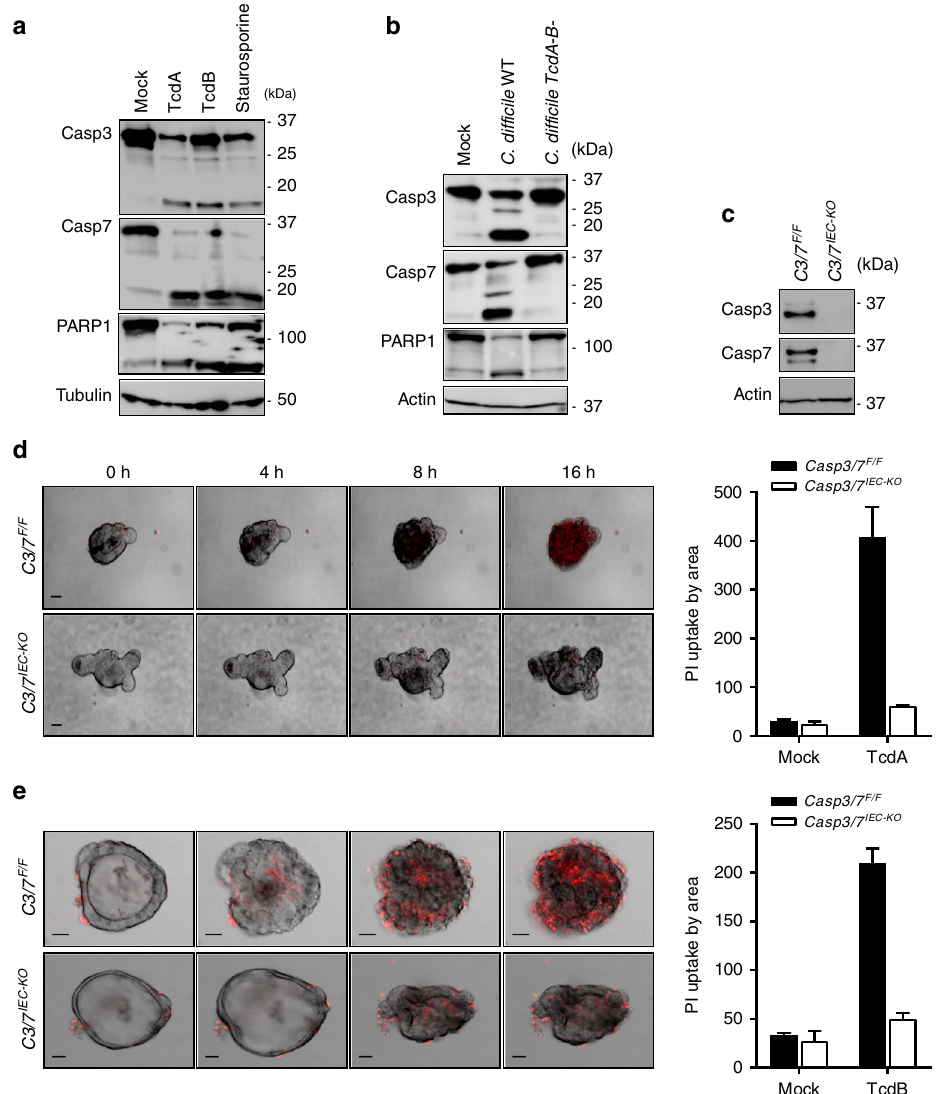
Fig. 3 Apoptotic executioner caspases 3 and 7 are critical for C. dif fi cile toxins-induced IEC death. a , b Wildtype (WT) primary intestinal organoids were stimulated with a TcdA and TcdB for 16 h or staurosporine for 3 h, or b infected with a toxigenic and non-toxigenic strain of C. dif fi cile for 16 h. Cell lysate